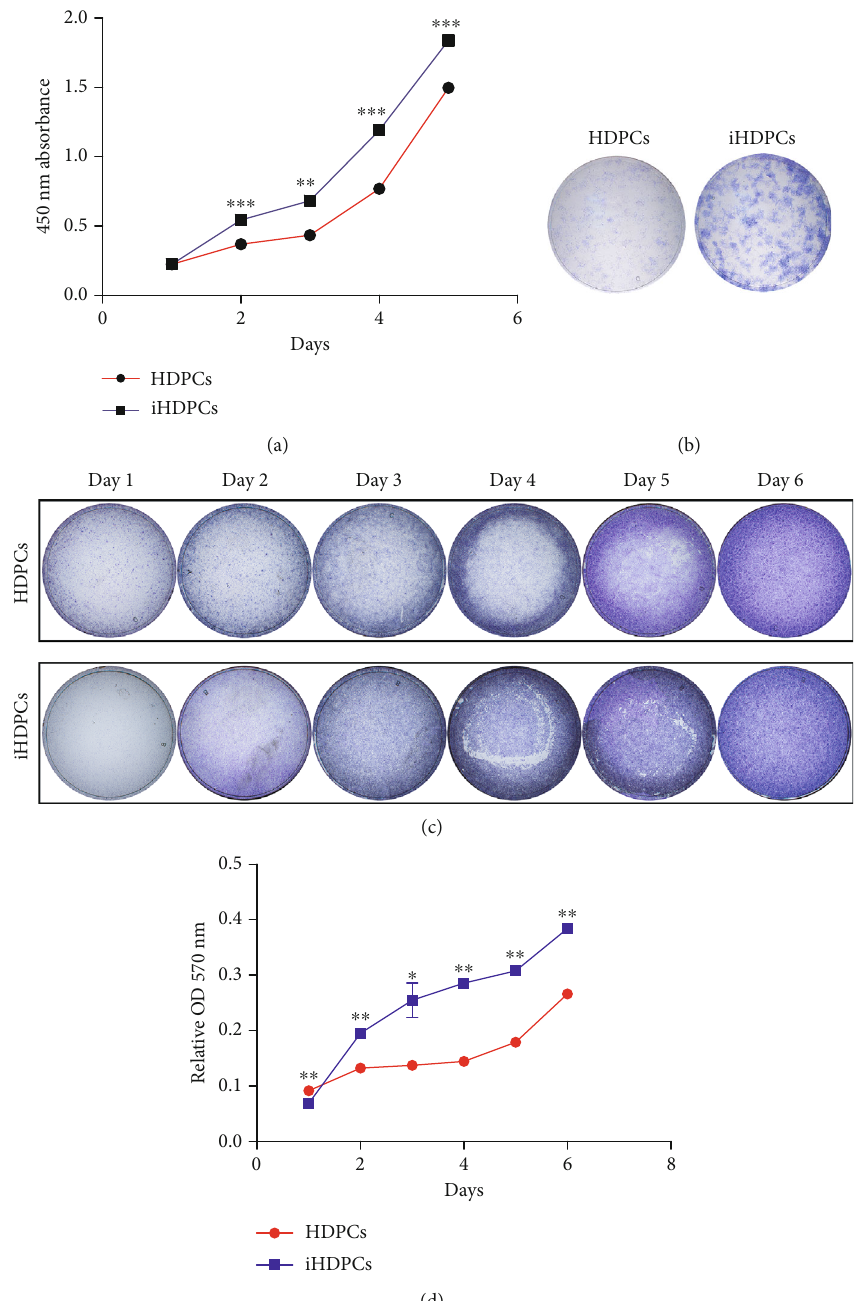
Figure 2: IHDPCs acquired strong self-renewal and proliferation ability. (a) Cell proliferation was observed by the CCK8 assay ( ∗∗ P < 0 : 01 , ∗∗∗ P < 0 : 001 ). (b) Colony formation assay using crystal violet staining. (c) Cell proliferation assessed by the crystal violet staining assay. (d) The stain extracted from the cells was dissolved for quantitative determination at A570 nm ( ∗ P < 0 : 05 , ∗∗ P < 0 : 01